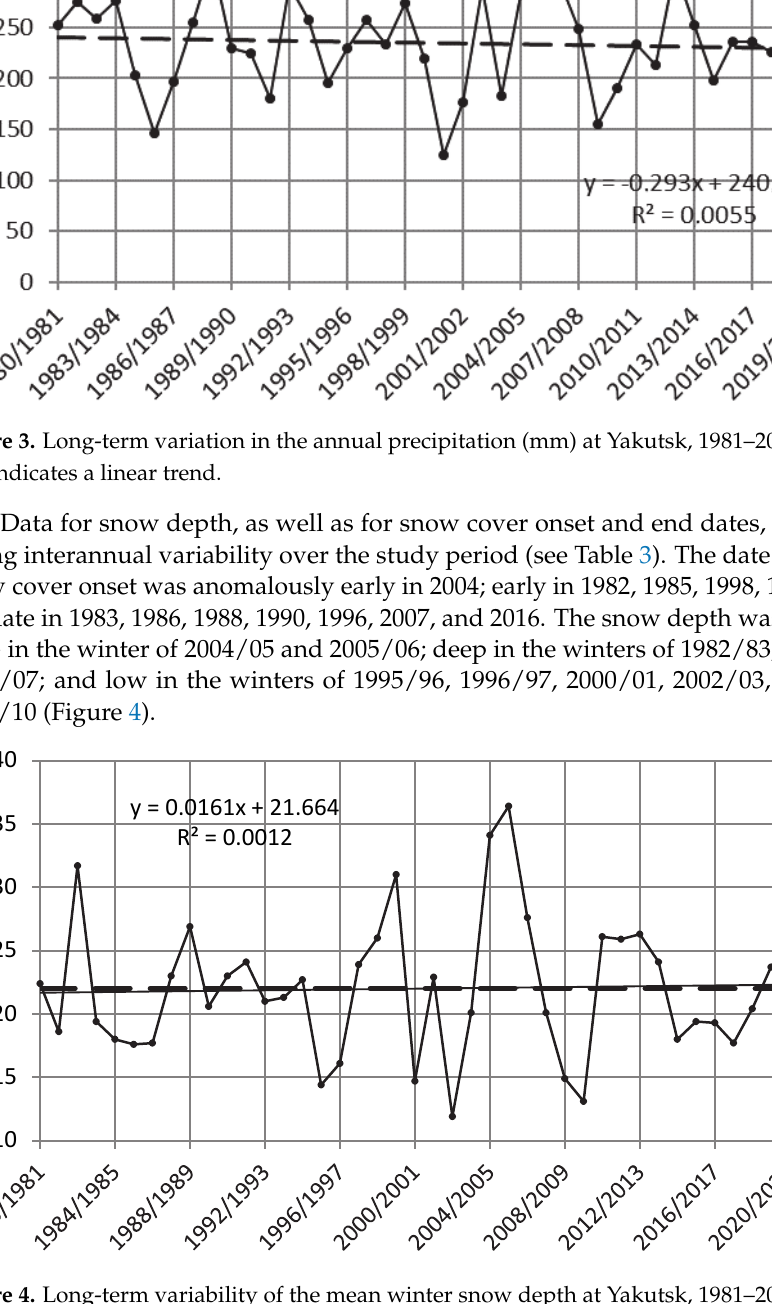
Figure 4. Long-term variability of the mean winter snow depth at Yakutsk, 1981–2021. The dashed line indicates a linear trend.